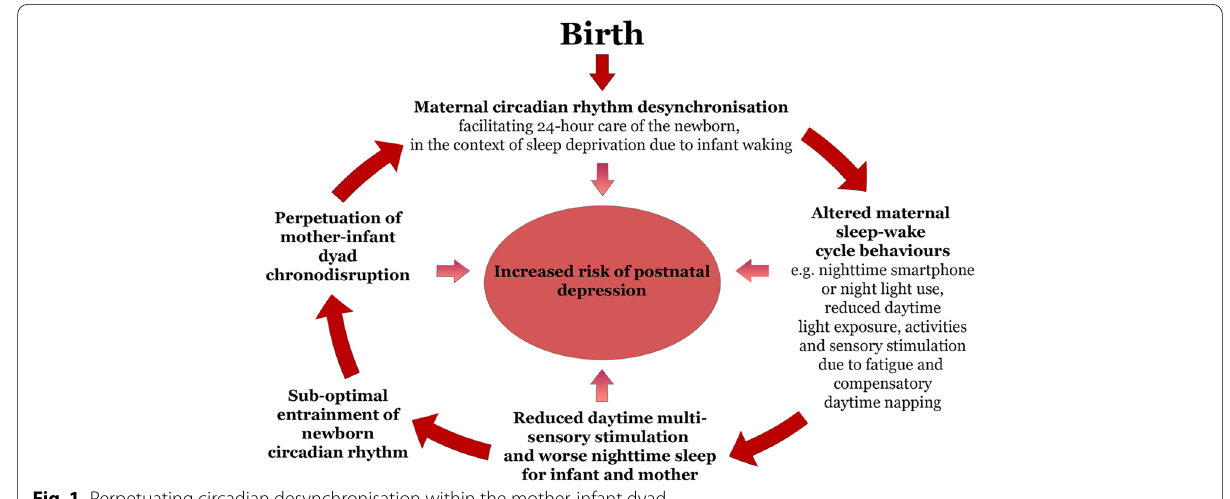
Fig. 1 Perpetuating circadian desynchronisation within the mother-infant dyad